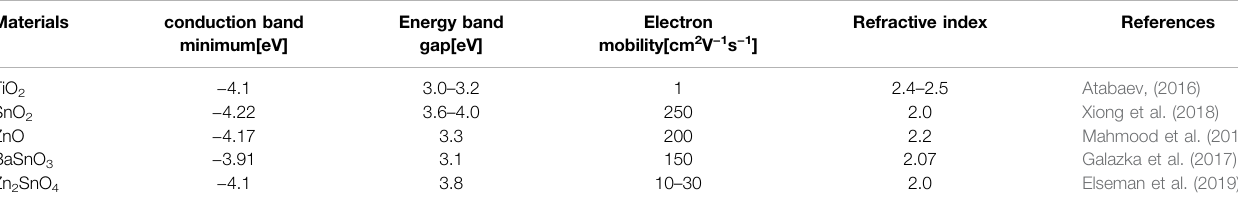
TABLE 1 | Comparison of electrical properties of common ETL materials.